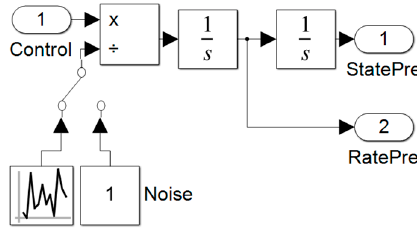
Figure A6. Closed-loop real-time optimal controller topology.